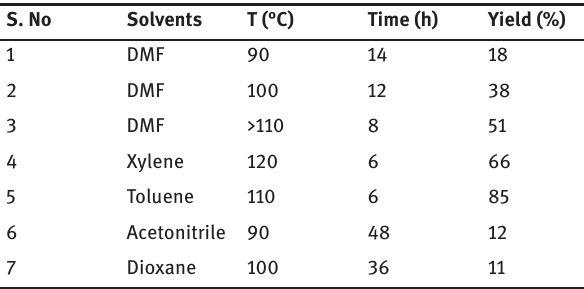
Table 1: Optimization for the synthesis of 3,4-dihydro-9-arylacridin- 1(2 H )-ones based